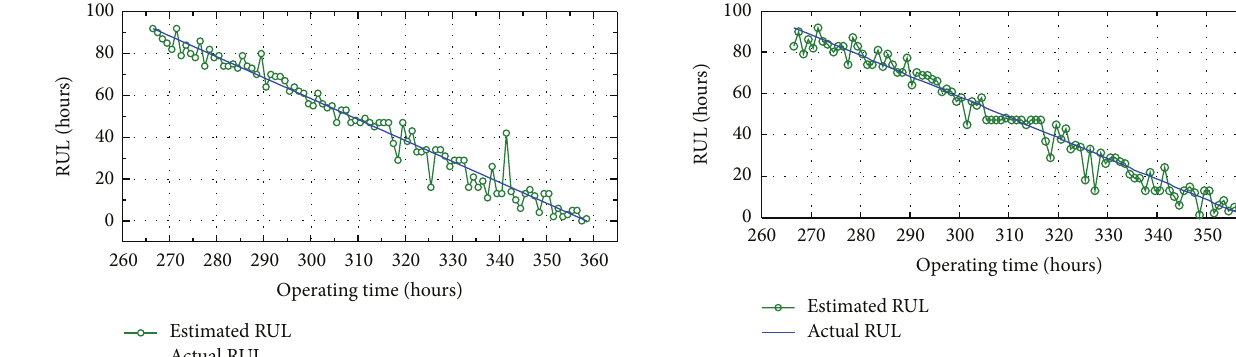
Figure 19: RUL estimation for the ball-fault case based on original signal